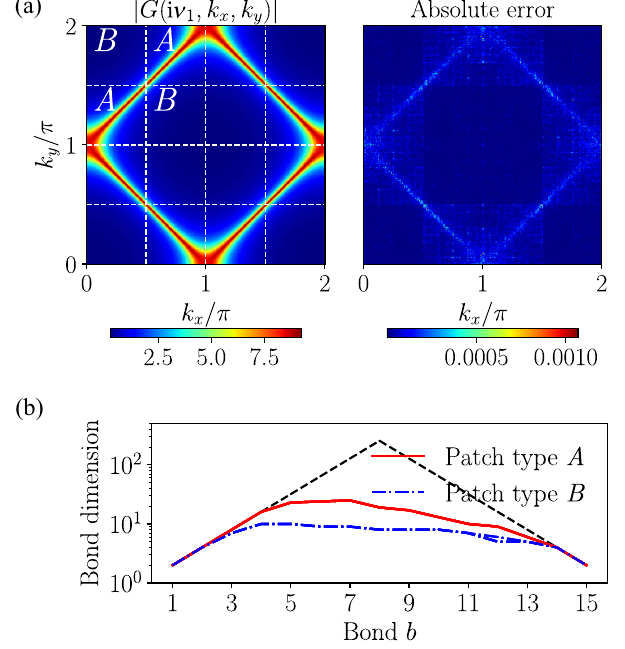
FIG. 11. Green ’ s function of the 2D Hubbard model solved within FLEX at the lowest positive Matsubara frequency. (a) Intensity map of the original data and the error in the reconstructed data. The full BZ is divided into 16 patches. (b) Bond dimensions for all 16 patches. The dashed line indicates the maximum bond dimensions in maximally entangled cases. The compression ratios are 10.86 and 45.20 for the patches A and B , respectively. Here, the compression ratio is defined as the ratio between the number of elements in a TT and that of the original tensor.